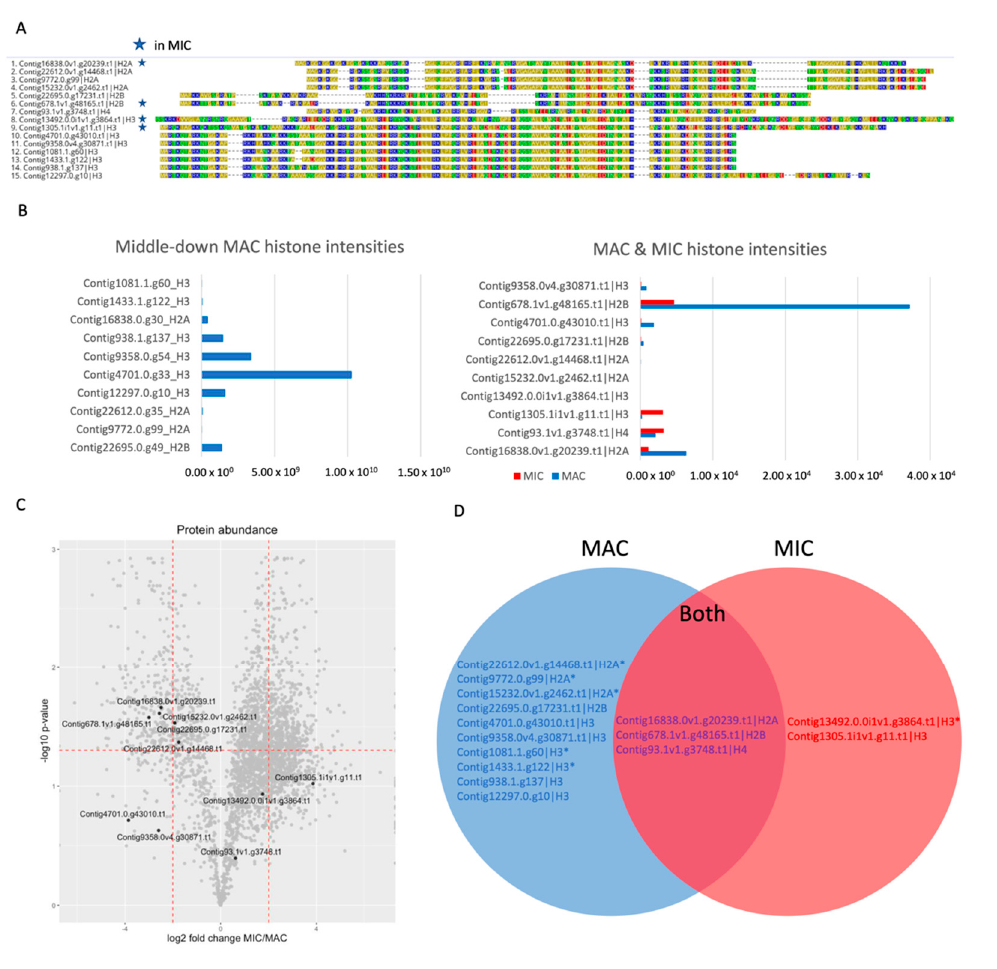
Figure 3. Differences in histone composition between MAC and MIC. ( A ) Alignment of all histones identified in both MS datasets. The first 425 residues and last 60 residues of Con- tig13492.0.0i1v1.g3864.t1 were omitted. Histones that are present in the MIC are starred. ( B ) Overall ion intensities (AU) for H2A, H2B, and H3 variants found in the middle-down MAC histones and separated nuclear samples. The middle-down dataset identified more histone variants than the nuclear dataset, likely due to the differences in sample preparation. ( C ) Volcano plot marking all the histones from the nuclear MS dataset. While only the MIC-specific H3 variants appear in the MIC-enriched fraction, there is a single H2A and H2B variant that has a high overall ion intensity from the MIC samples. ( D ) Venn diagram of histone presence among the two nuclei. Histones marked with an asterisk are present at low levels.